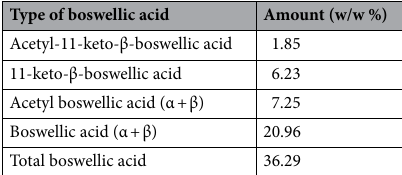
Table 1. Quantity (%) of different boswellic